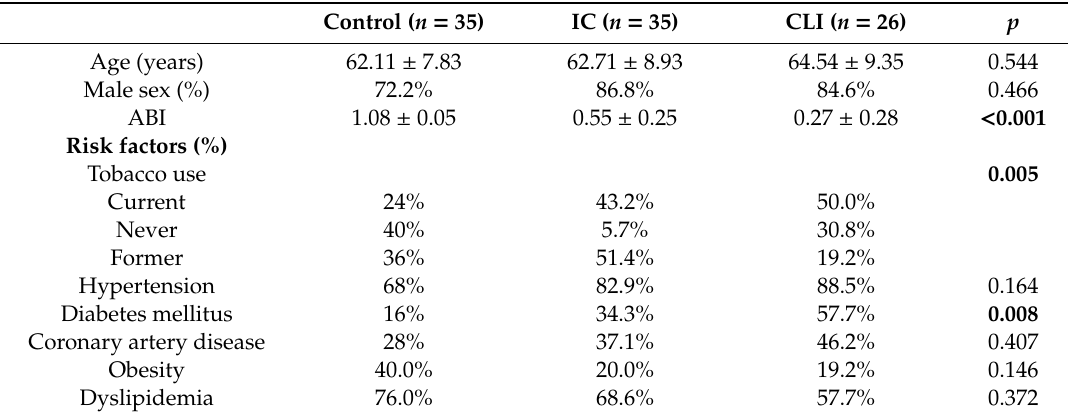
Table 1. Participant demographics at